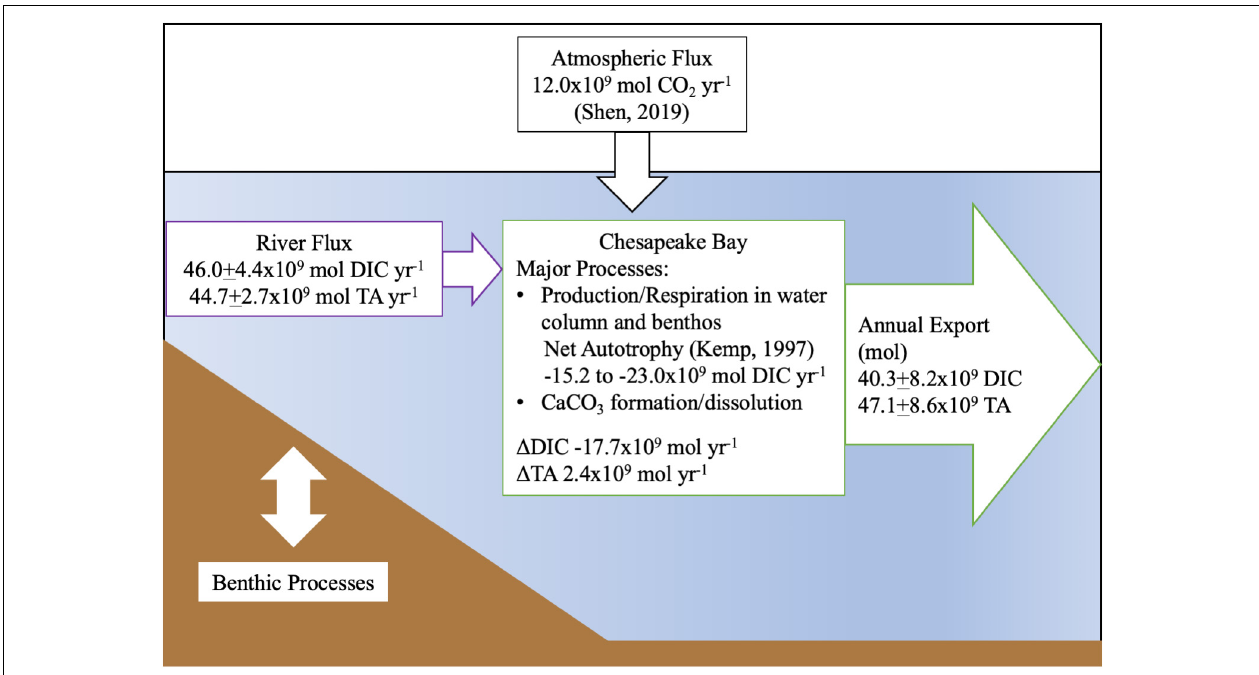
FIGURE 10 | Summary of estimated riverine DIC and TA flux into the Chesapeake Bay and estuarine export to the Atlantic Ocean in 2016. The atmospheric flux estimate is from Shen et al. (2019) and the metabolic rate estimate from Kemp et al. (1997).